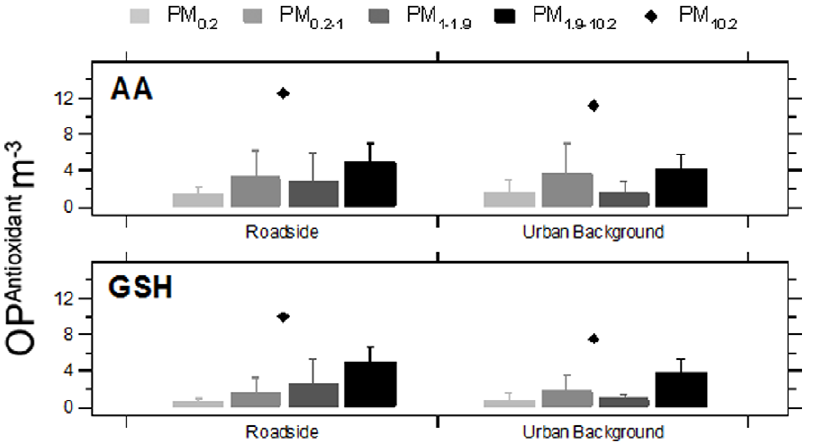
Figure 5. Mean size-fractionated PM ascorbate and glutathione related oxidative potential at primary school grouped by roadside and urban background site types. See the Figure 2 legend for a description of marker and statistical details.